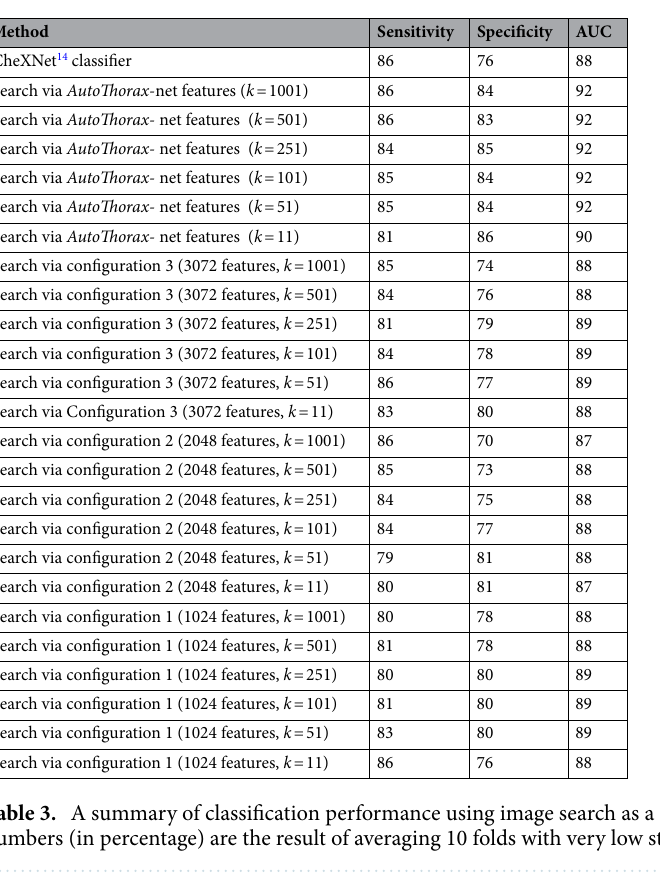
Experimental workflow. We constructed the receiver operating characteristics (ROC) curve for Dataset 2 to find the trade-off between sensitivity and specificity (Fig. 9). We used Youden’s index to find the trade-off posi- tion on the ROC curve providing the threshold for match selection. A standard tenfold cross-validation was adopted for testing that showed a very low standard deviation (< 1%) for all experiments apparently due to the large size of the datasets. All chest X-ray images were divided into 10 folds. In each fold, one group of chest X-ray images was used as validation set, while the remaining chest X-ray images were used as archived set. The above process was repeated 10 times, such that in each fold a different group of chest X-ray images was used as the validation set. In each fold, an encoder was trained using the archived set of that fold. The encoder was then used for compressing deep features for each chest X-ray image in the validation set. The parameters of the encoder construction process were set as before described for Dataset 1. For image search, given a chest X-ray image (from the validation set), the compressed deep feature was used for searching in the archived set. The consensus vote among the top k retrieved chest X-ray images to classify the query image from the validation set. Experiments were conducted with k 11 , 51 , 101 , 251 , 501 , 1001 to observe the effect of more retrievals on consensus voting. For comparison, CheXNet 14 was adopted as a baseline to be applied to the validation set in each fold.